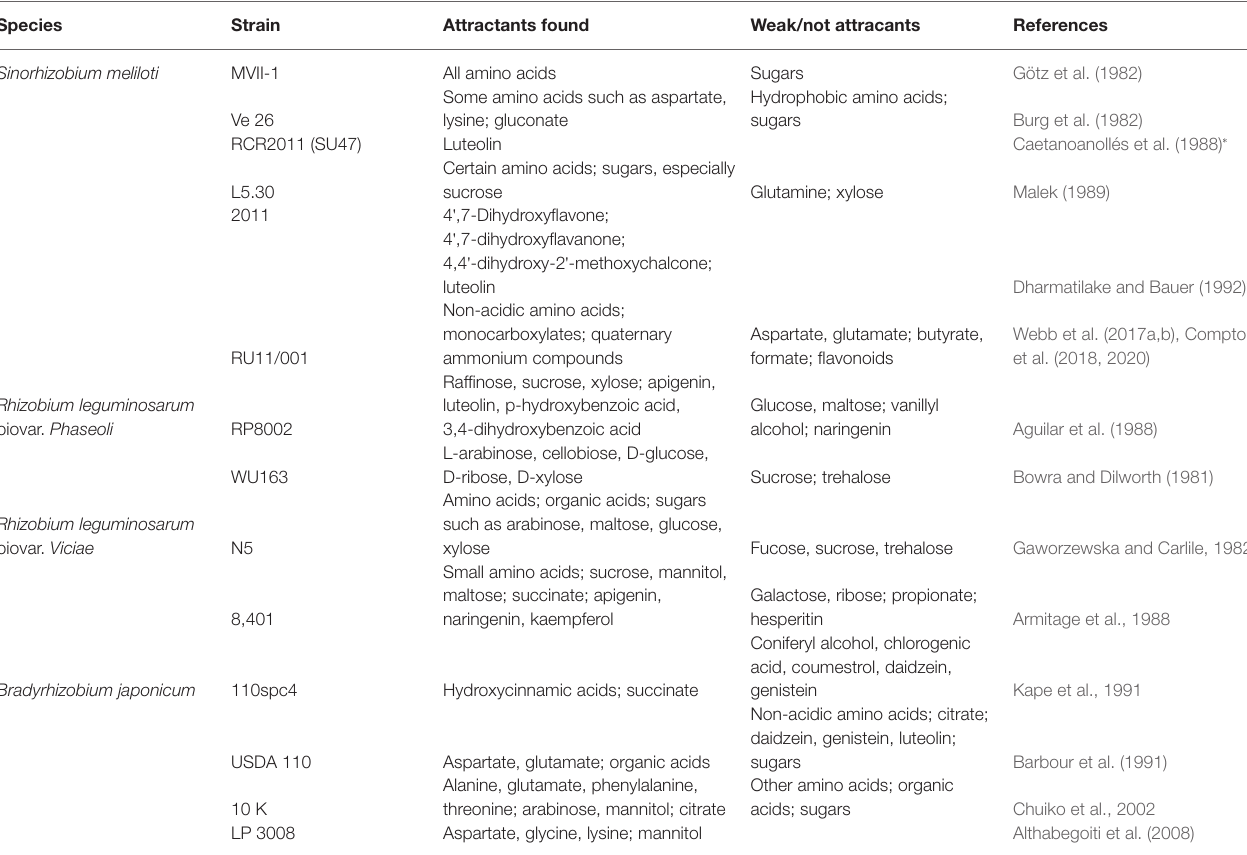
TABLE 1 | A catalog of the attractants identified in quantitative chemotaxis assays. Species Strain Attractants